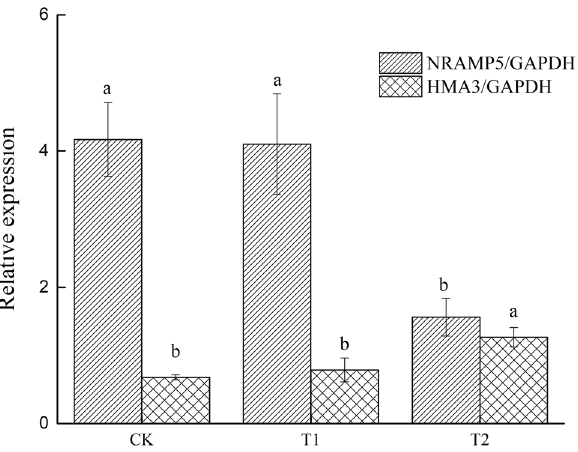
Figure 5. Relative expression of OsNramp5 and OsHMA3 genes in roots. Different letters represented significant difference at P < 0.05.